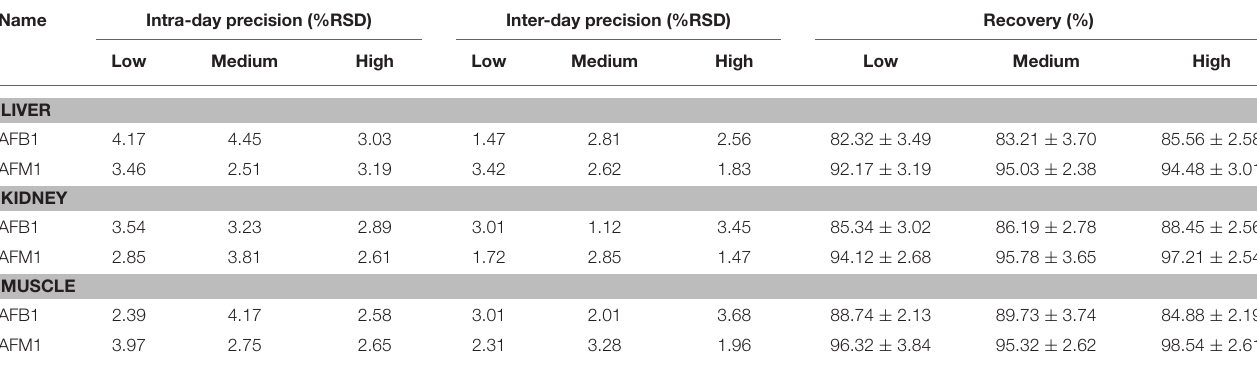
TABLE 4 | Mean recovery (%) and precision (%RSD) (intra-day precision and inter-day precision) of AFB1 and AFM1 ( n = 5) in liver, kidney, and muscles tissues. Name Intra-day precision (%RSD) Inter-day precision